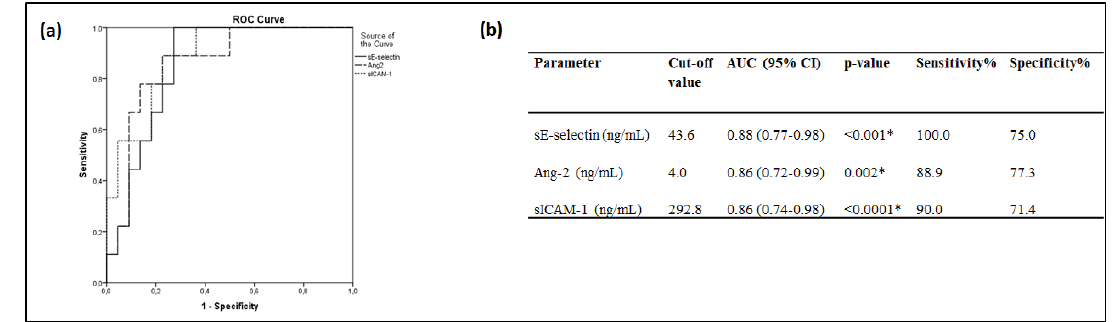
Figure 4. Admission biomarker levels and intensive care unit (ICU) mortality. Receiver operating characteristic (ROC) curve analysis. ROC curves were generated to determine the prognostic accuracy of either sE-selectin, Ang-2 or sICAM-1, as measured on ICU admission (within 24-h). a) ROC curves; sE-selectin, solid line; Ang-2, dashed line; sICAM-1, dotted line. b) The corresponding areas under the curve (AUC), 95% confidence intervals (CI) and the optimal cut-off values with the greatest combined sensitivity and specificity are given. * p -value< 0.05. Ang-2 = Angiopoietin-2; s = soluble; sICAM-1 = soluble Intercellular adhesion molecule 1.